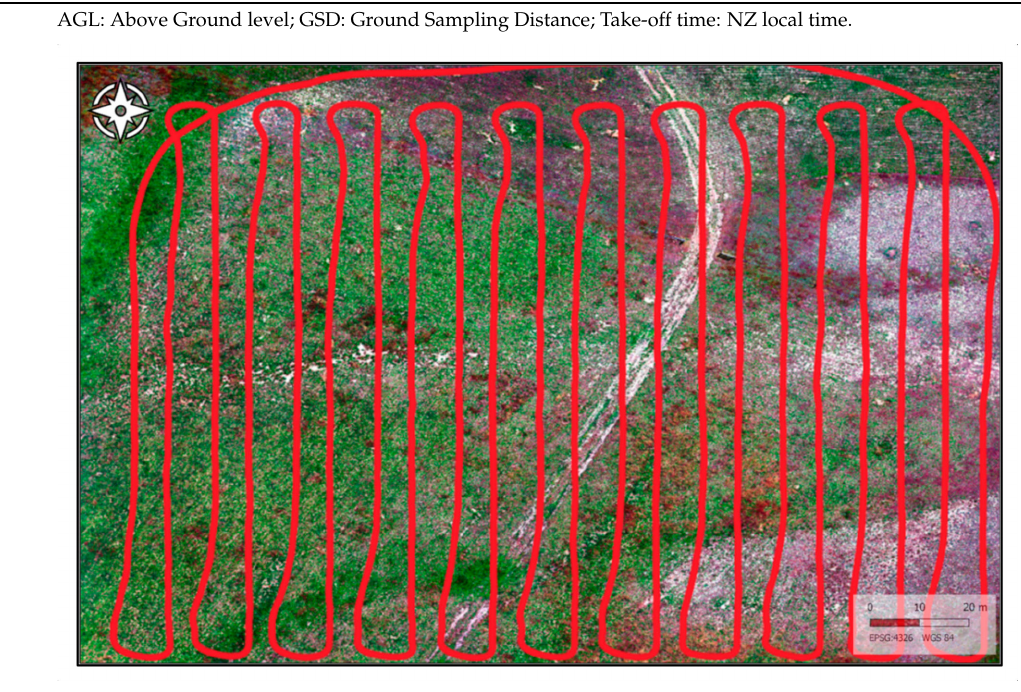
Figure 3. Lawn mower pattern of UAV mission (EPSG:4326—WGS